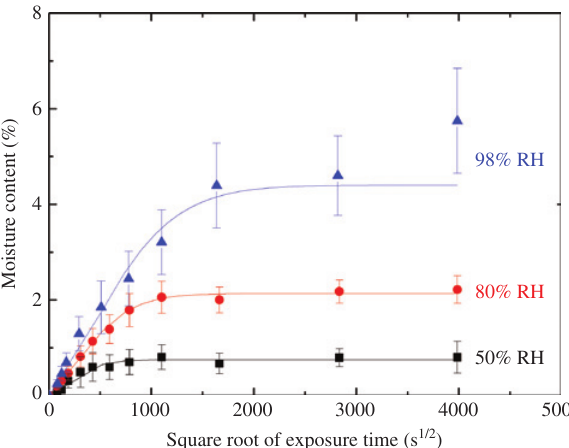
Figure 1 Moisture uptake curves of ramie fiber fabric reinforced phenolic resin under three kinds of humidity at room temperature. Note the solid lines represent the curve fitting results with Equation